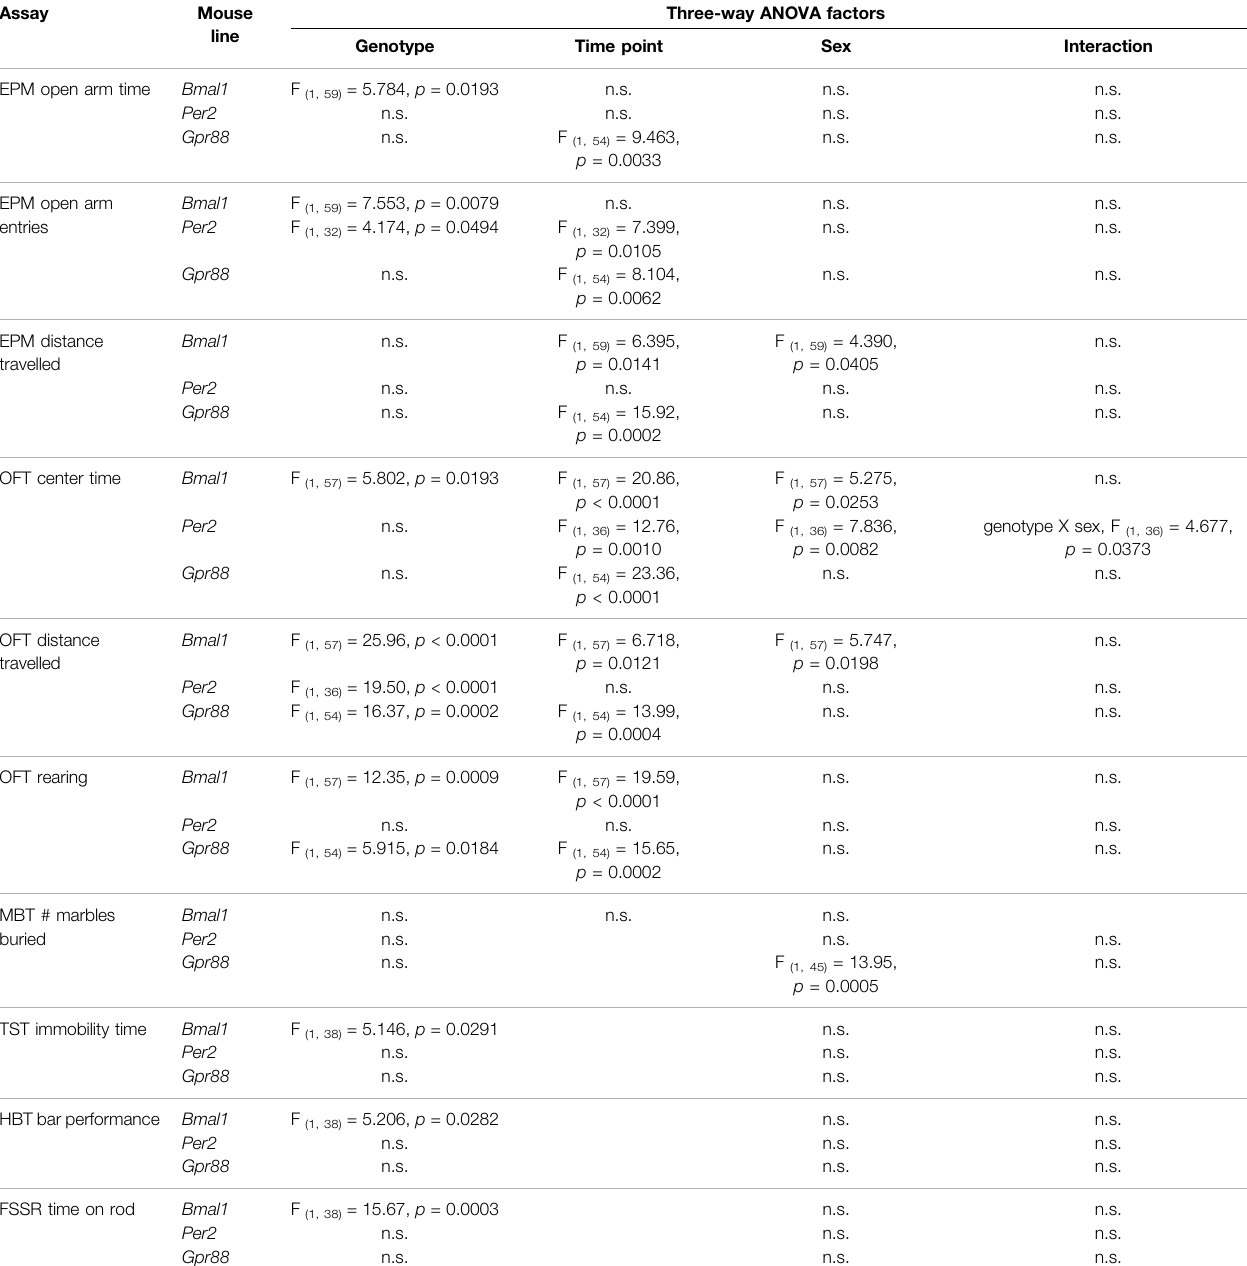
TABLE 2 | Statistical analysis of affective behaviours and motor function. Assay Mouse